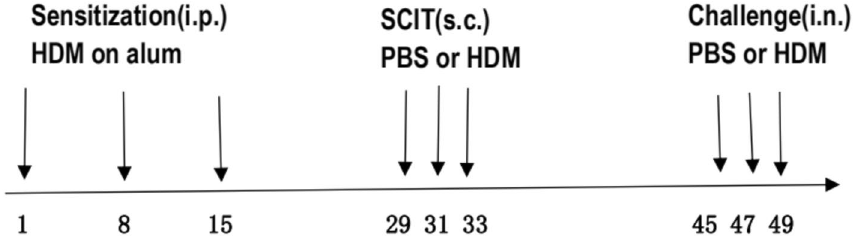
Figure 7. Schematic representation of the experimental allergic rhinitis model and treatment protocol.